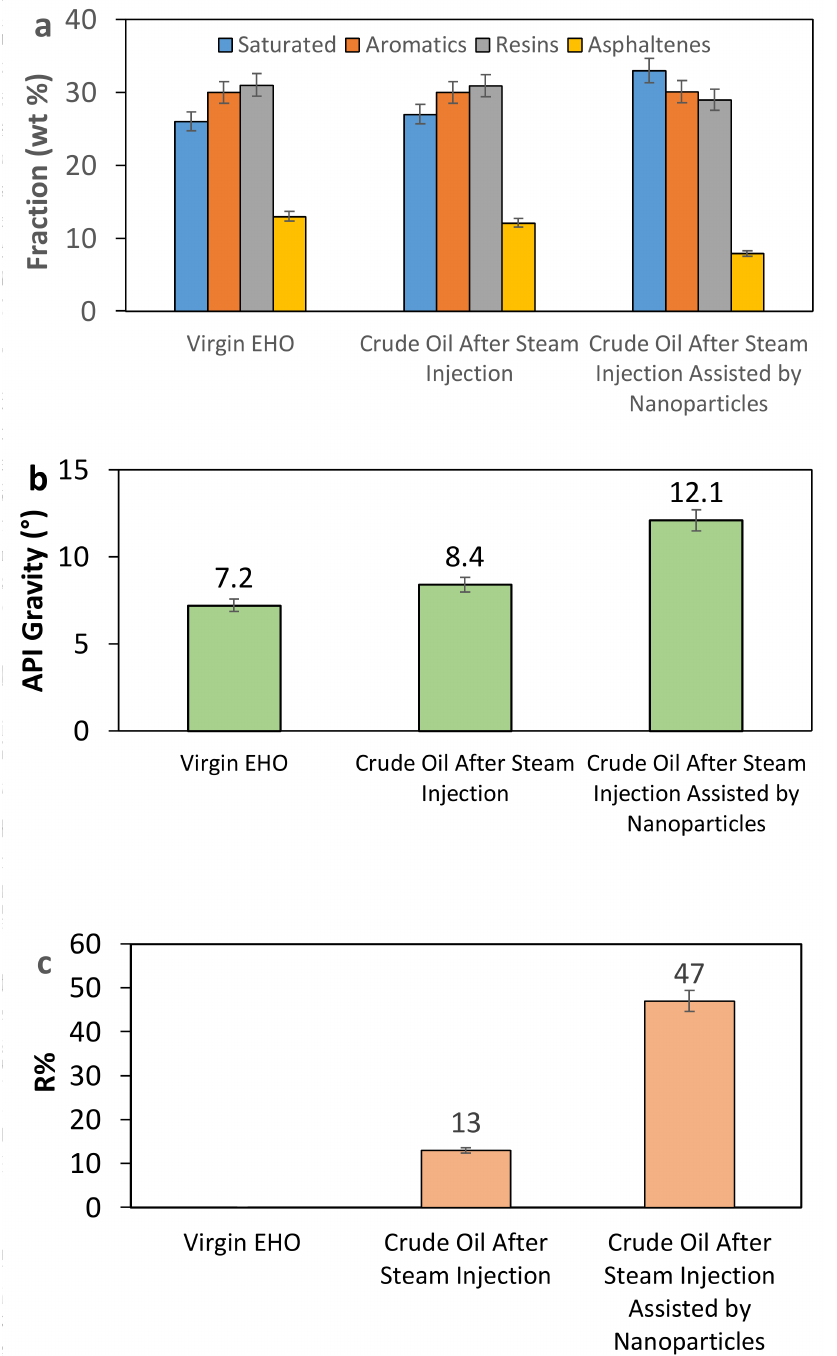
Figure 2. ( a ) Saturates, aromatics, resins and asphaltene content (SARA) analysis, ( b ) API gravity and ( c ) residue (620 ◦ C+) conversion (R%) for an extra heavy crude oil before and after recovery with steam injection in the presence and absence of 1000 mg/L of SiNi1Pd1 nanoparticles. Injection pressure and temperature were maintained at 8.96 MPa (1300 psi) and 300 ◦ C,